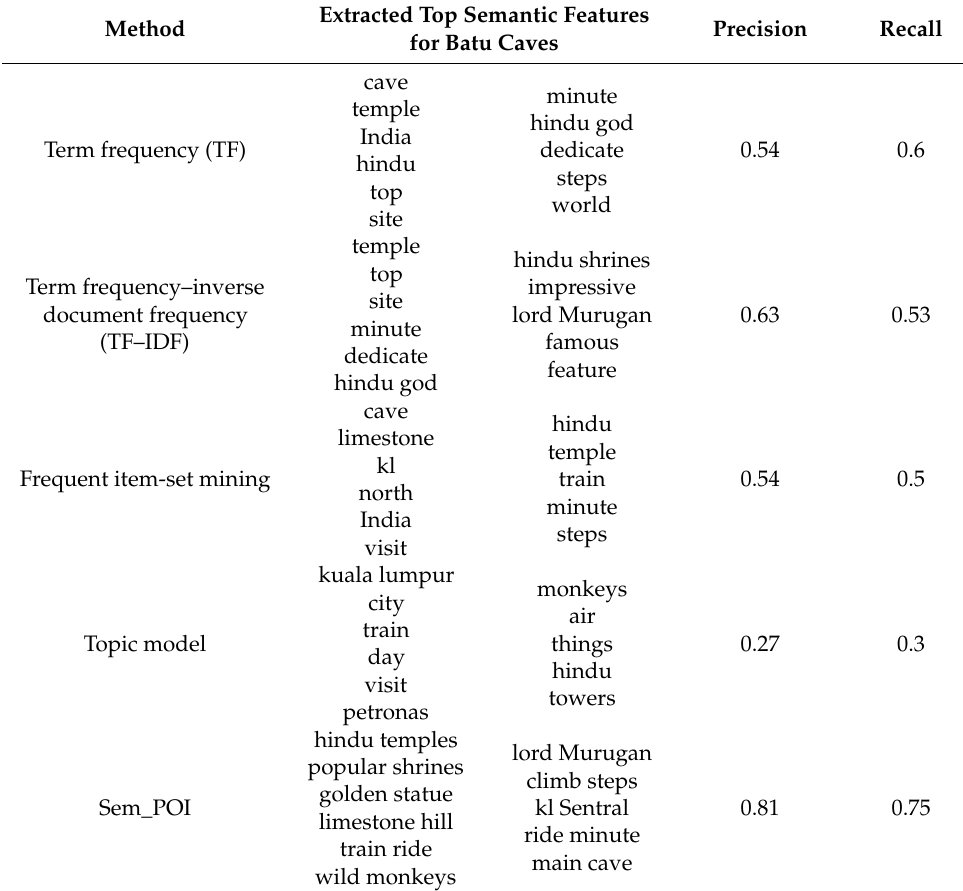
Table 5. Extracted top semantic terms of the baseline and proposed methods.